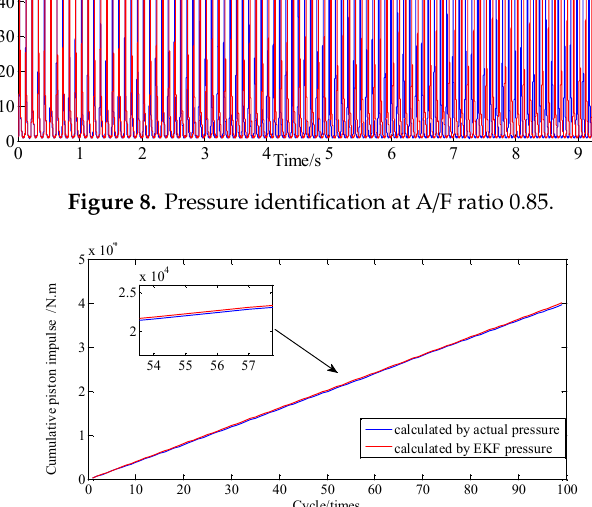
Figure 9. Piston impulse accumulated at A/F ratio 0.85.